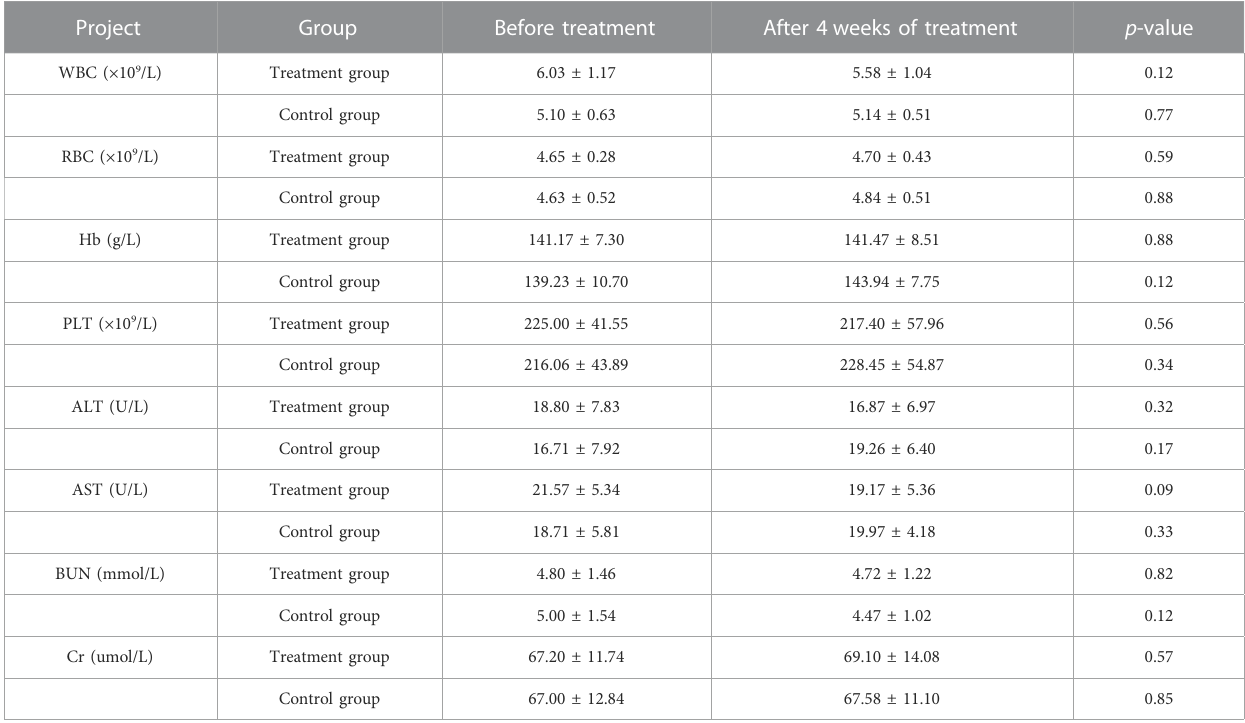
TABLE 2 Safety index evaluation. Project